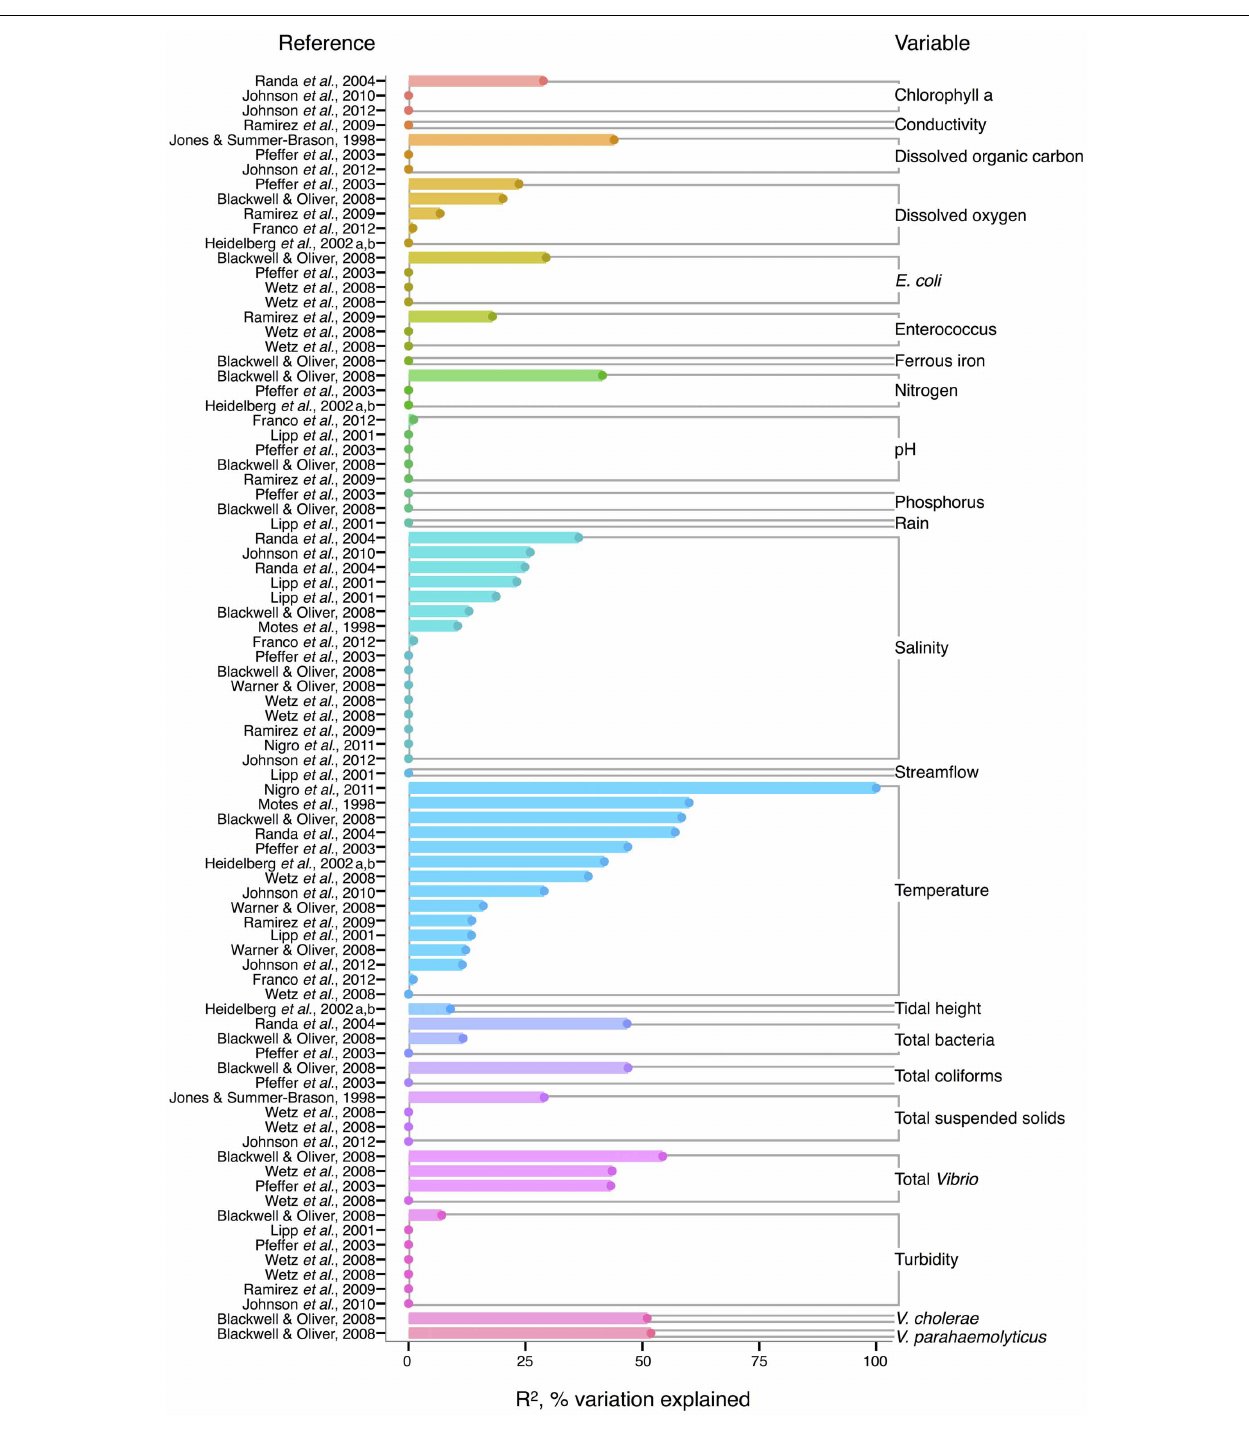
FIGURE 4 | Variation in V. vulnificus abundance or percent positive samples is best explained by temperature, and other organisms, including Vibrio . R 2 , or pseudo- R 2 , values from analyses across studies are depicted grouped by variable, and then in rank order, with their associated